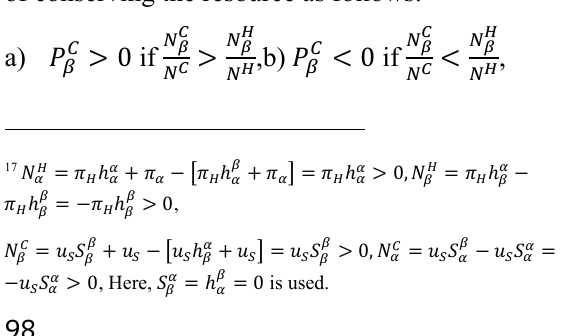
(cid:1871)(cid:1861)(cid:1859)(cid:1866)(cid:3419)(cid:1842)